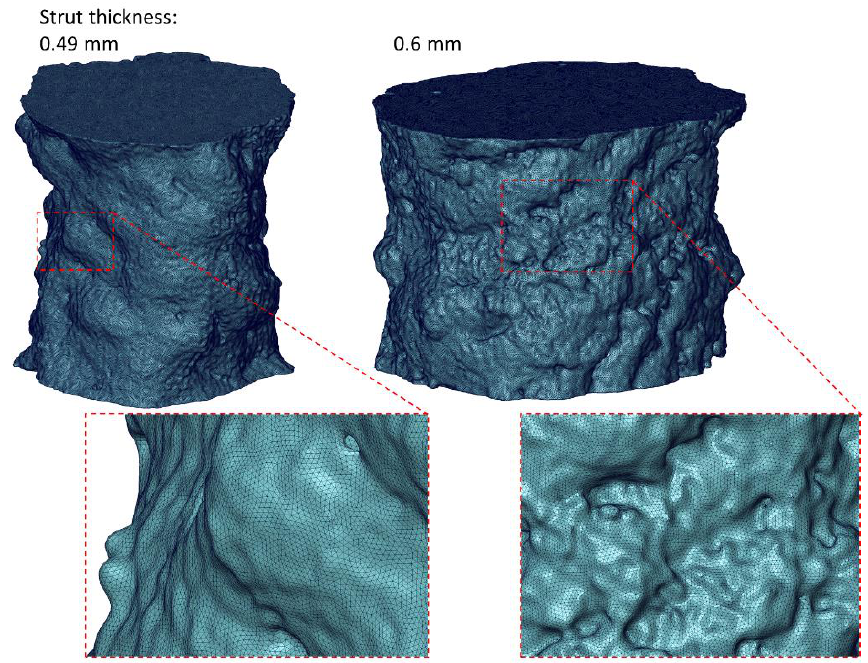
Figure 1. Division into finite elements of the examined material structures.